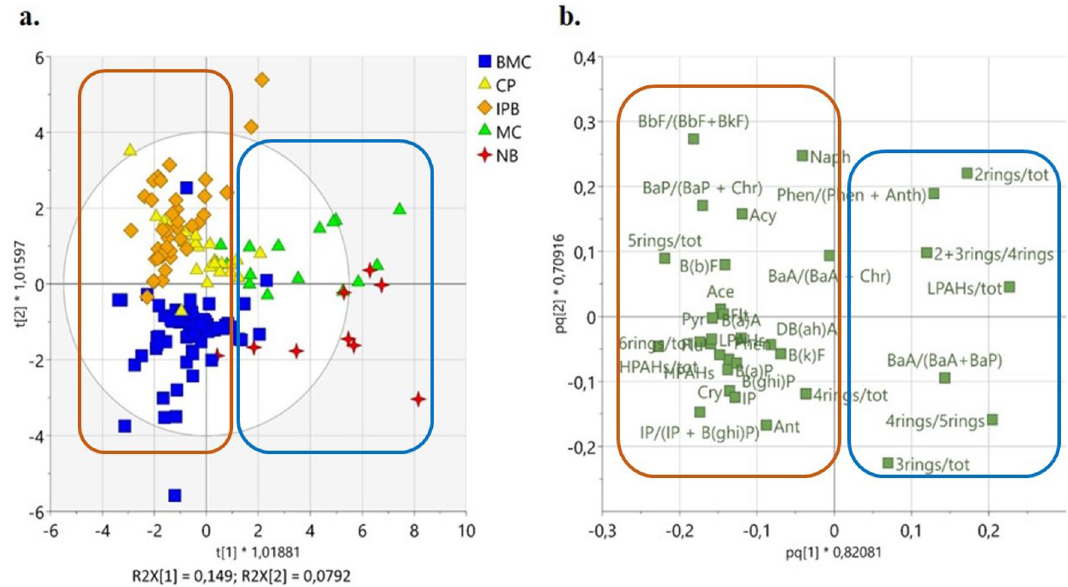
Figure 3. OPLS-DA applied to all classes (MC = Marine Coastal Transect; NB = Natural Bay; BMC = Mar Piccolo Basin; CP = Commercial Port; IPB = International relevance port): t1/t2 score plot ( a ) and p1/p2 loading plot ( b ), relative to the first two predictive